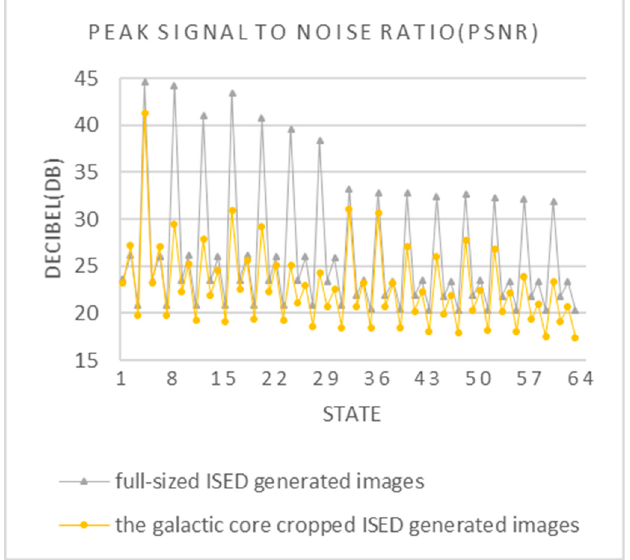
Figure 11. PSNR values of 63 ISED-generated images. The cropped images of M87 can be seen in Figure 9.